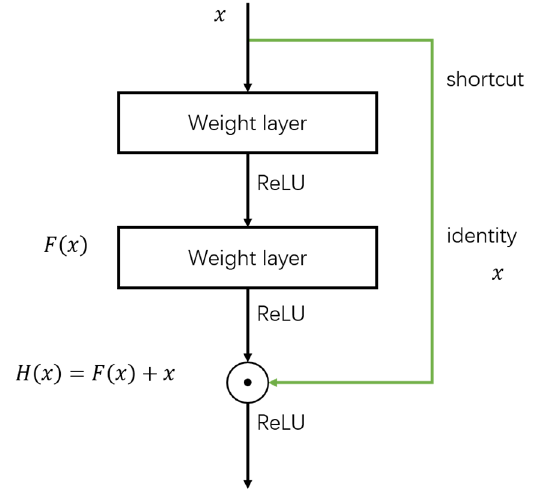
Figure 4. Structure of the residual block, which has a shortcut from the input layer directly connected to later layers.